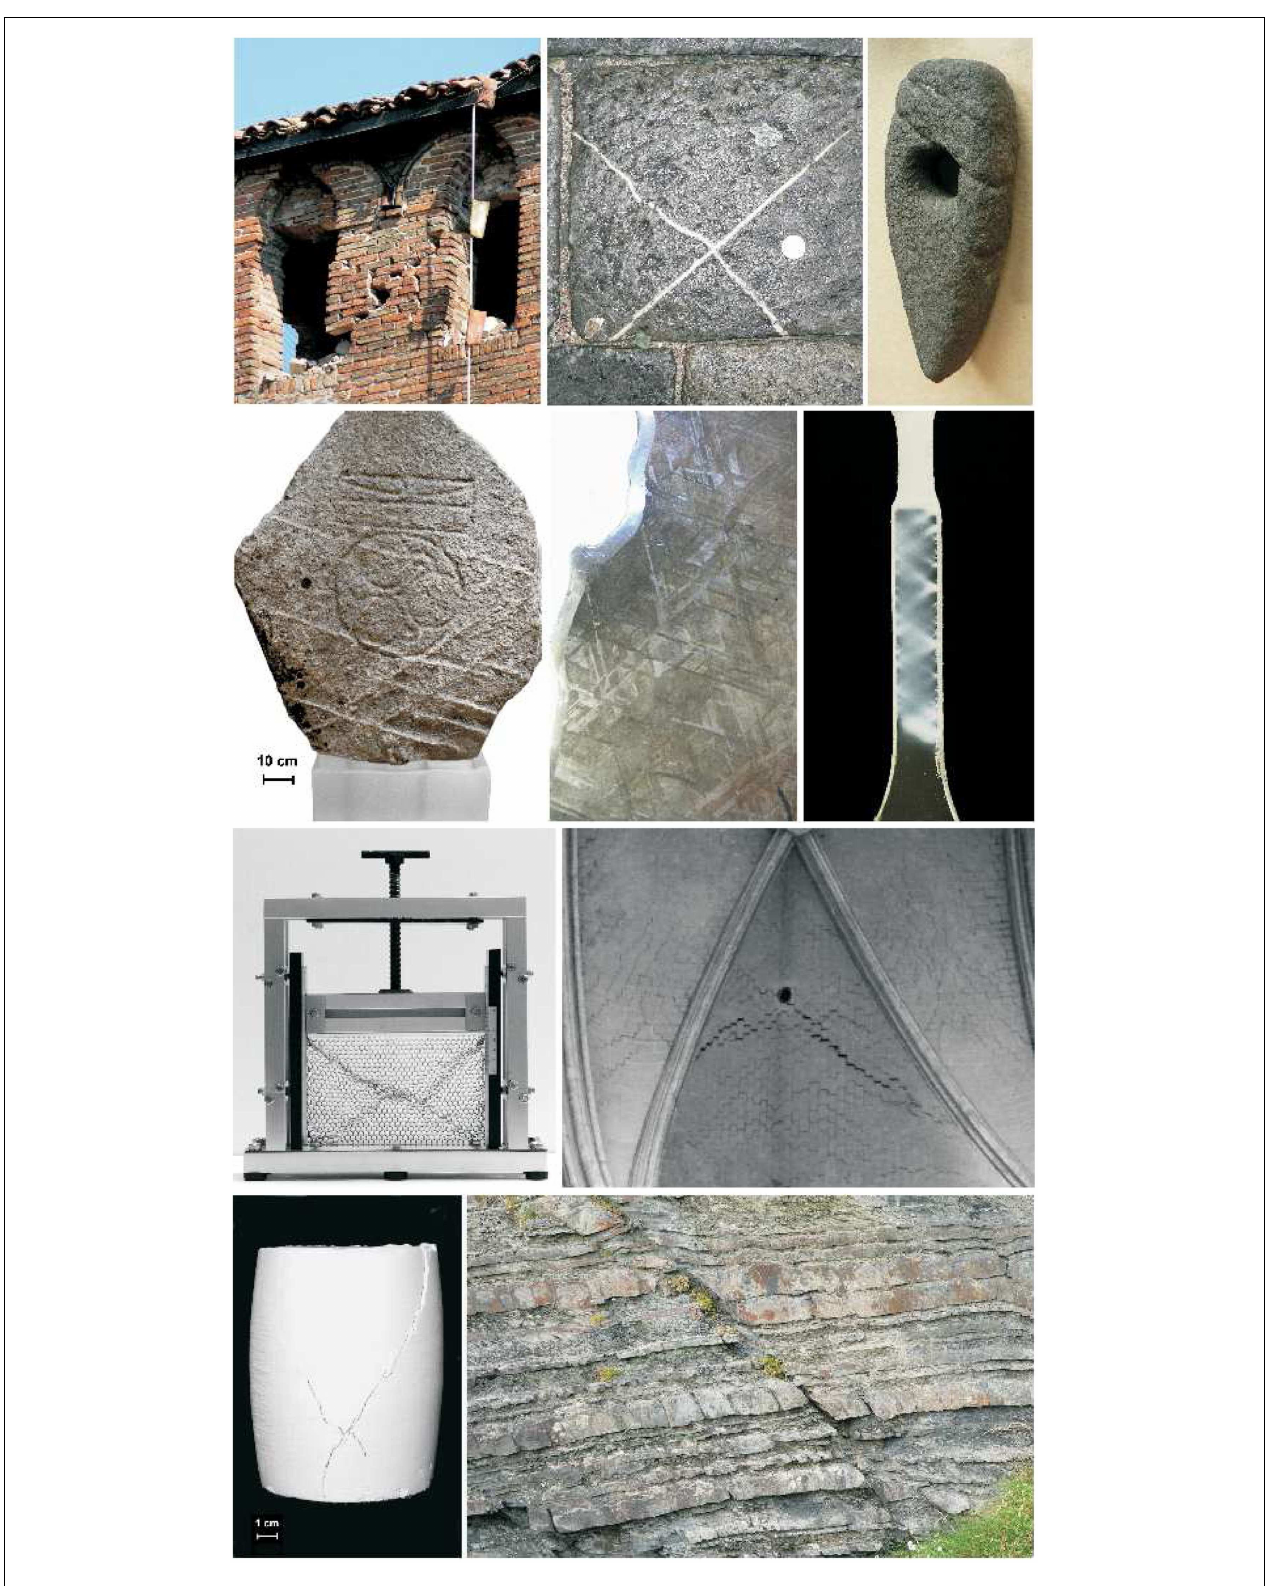
FIGURE 1 | Examples of strain localization